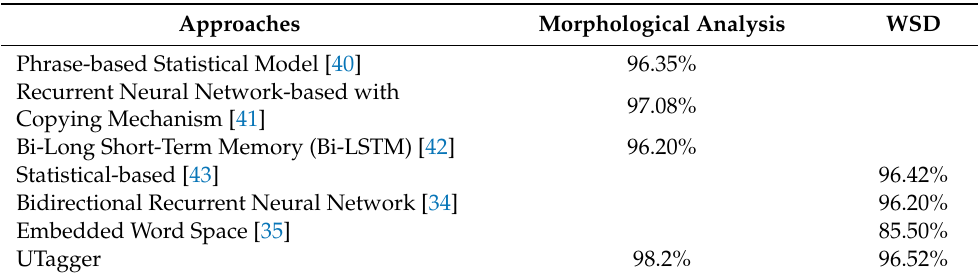
Table 7. The quality of the morphological analysis and WSD systems.